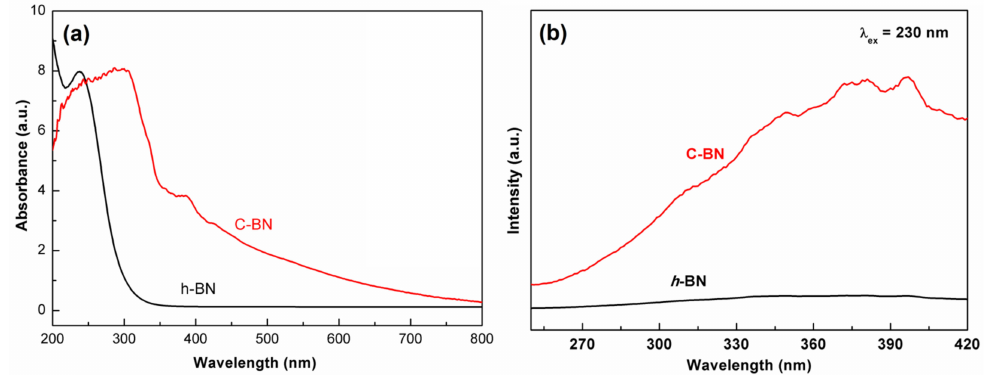
Figure 3. ( a ) UV–Vis DRS and ( b ) emission spectra (excited by 230 nm) of C-BN (red curve) and h -BN (black